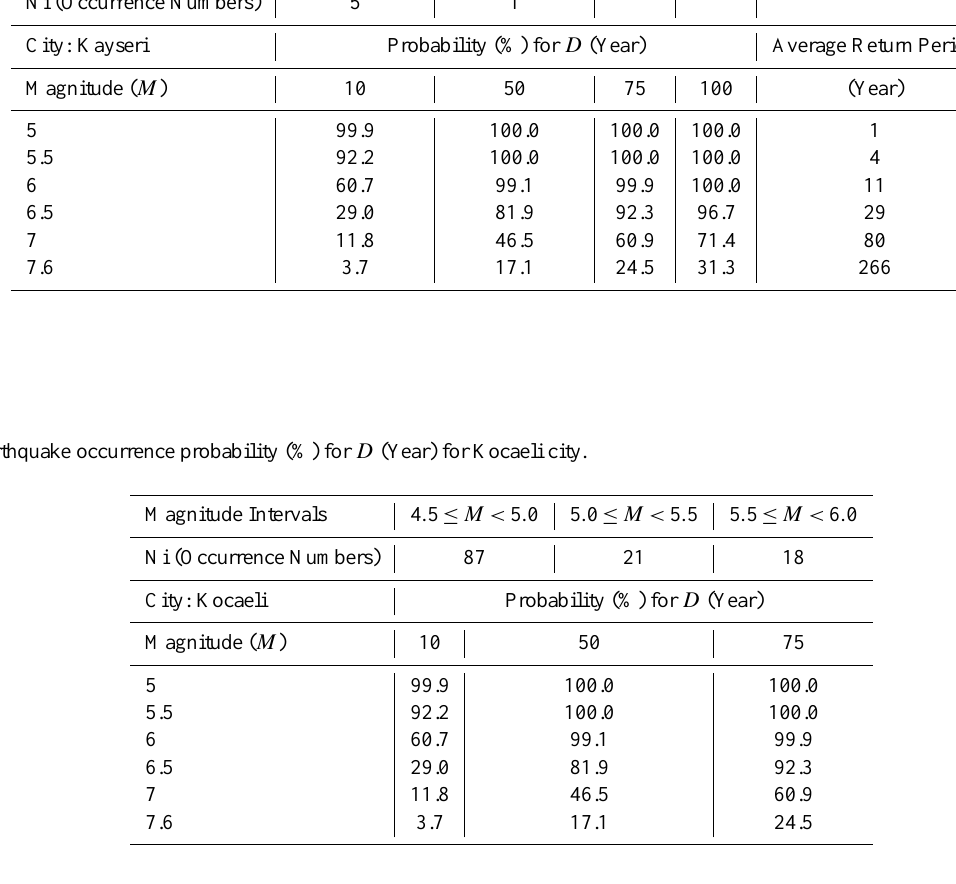
Table 3o. Earthquake occurrence probability (%) for D (Year) for Kayseri city. Magnitude Intervals